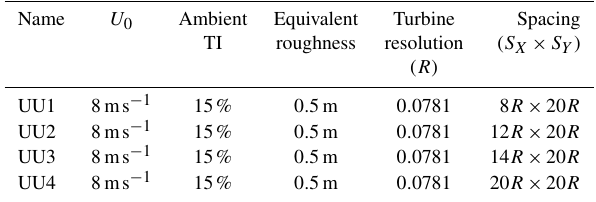
Table 3. Overview of simulations performed by UU. The simula- tions include 16 turbines and 30min of data. The vertical shear pro- file imposed within the PBL method is determined using the same equivalent roughness as the one used in the Mann algorithm to gen- erate turbulence (Mann,